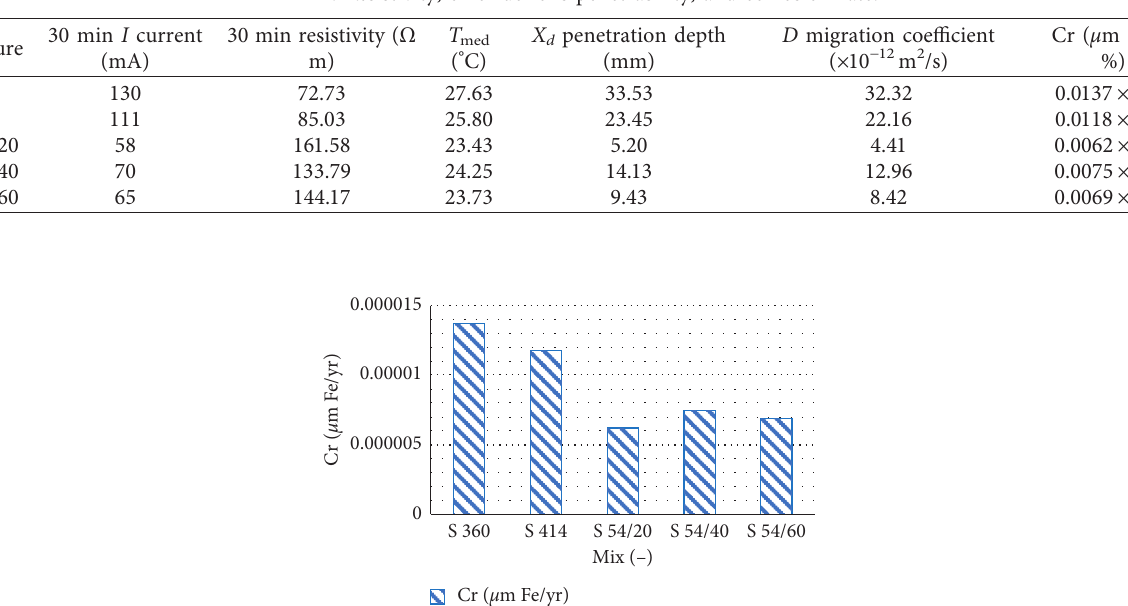
Figure 8: Corrosion rate ( C